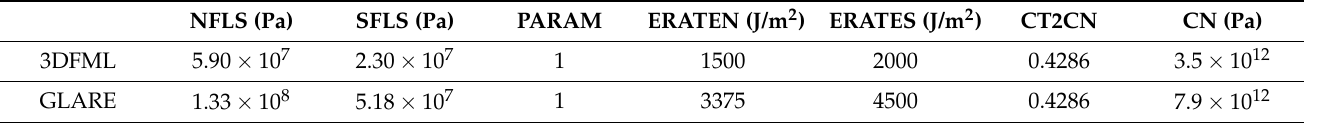
Table 3. CZM tiebreak contact parameters.